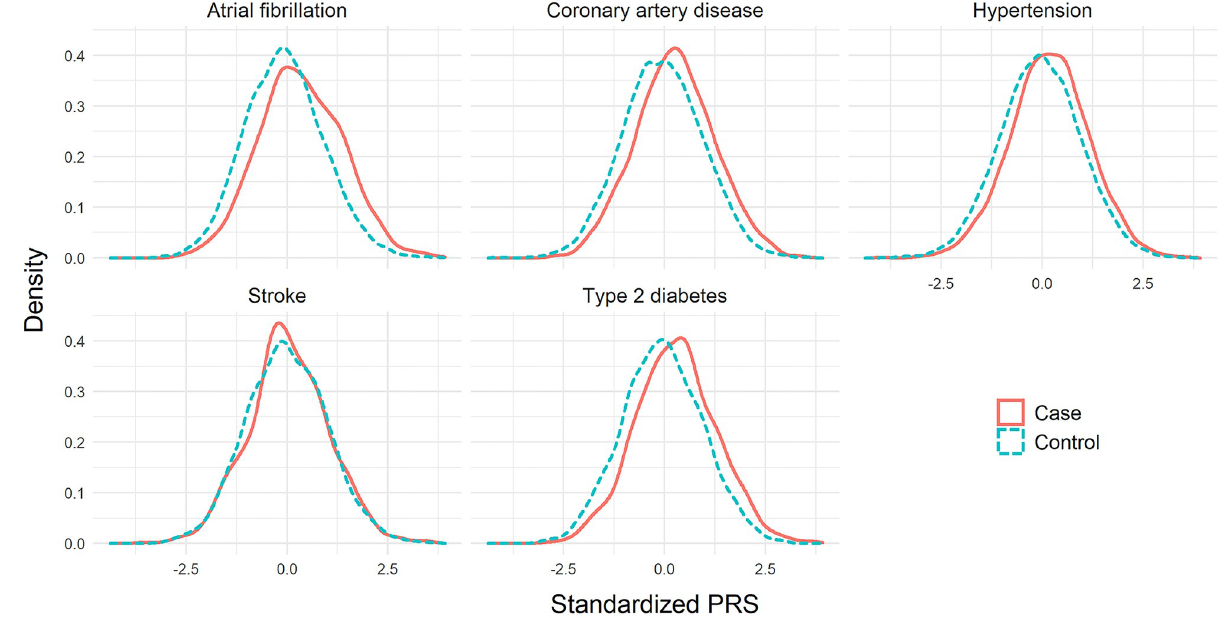
Fig 1. Distribution of the standardized SCT PRSs (with mean 0 and standard deviation 1) for the cases and controls in five common diseases.